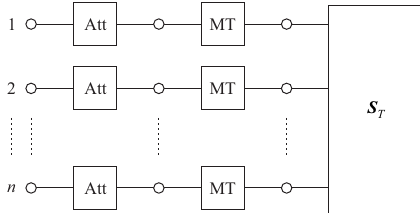
Figure 4. Passive noise model for pre-amplifiers in an n-channel coil array. In every channel the pre-amplifiers are modeled as the chain connection of a two-port matching transformer and an attenuator with S-parameters S MT and S Att , respectively. The S-parameters of the coil network that are transformed into the pre-amplifier plane are denoted as S T